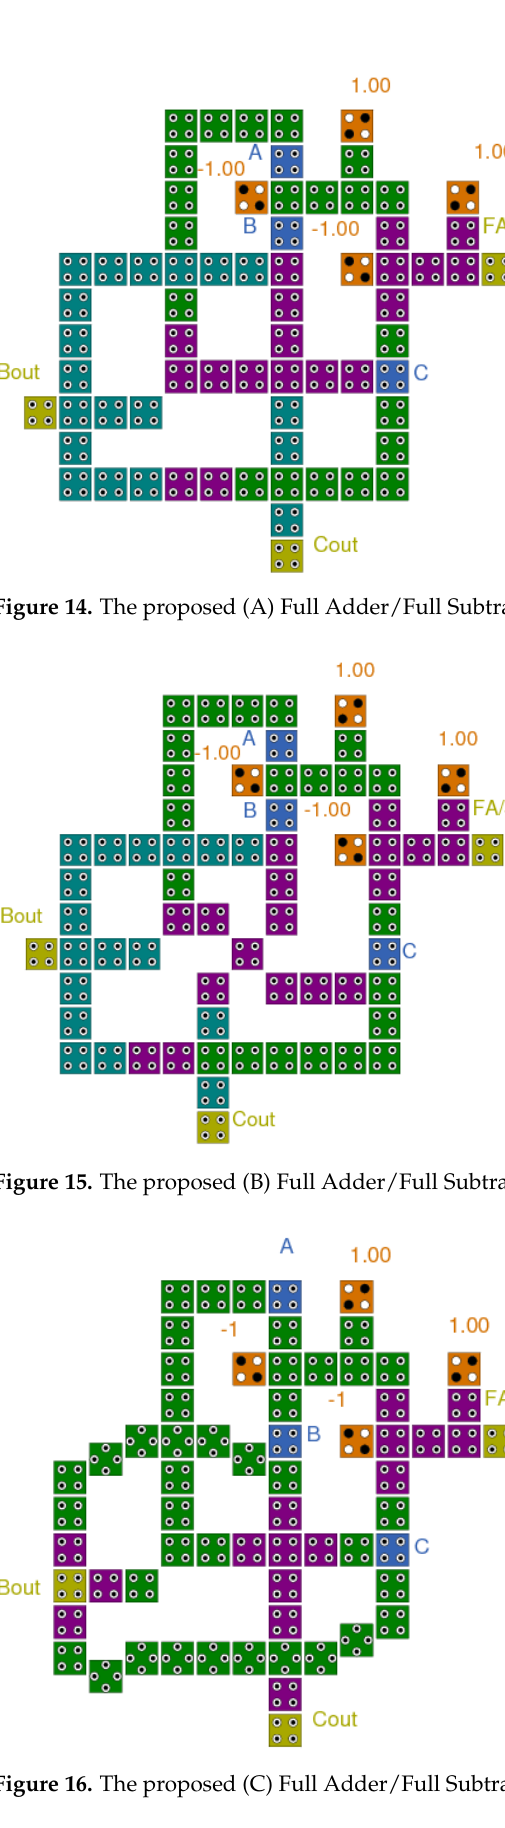
Figure 13. Simulation results of the proposed XOR-gate.